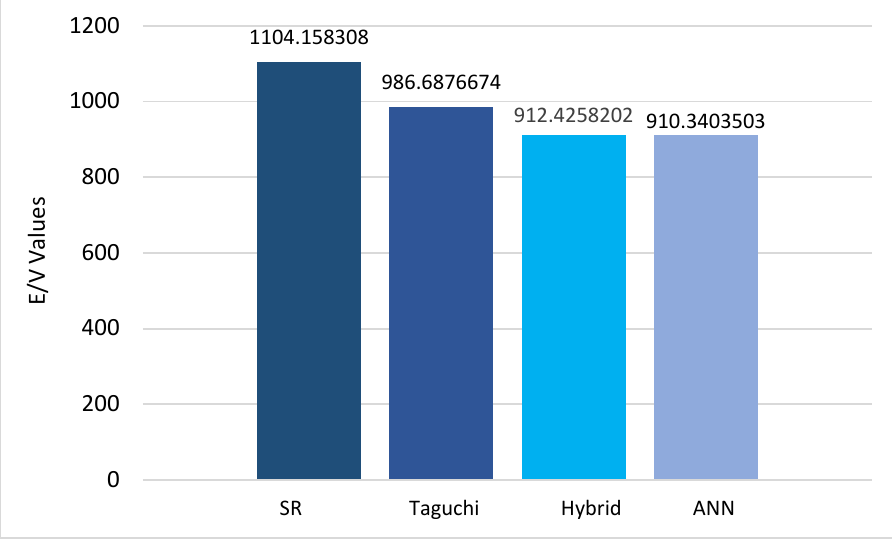
Figure 6. Comparison of E/V values obtained through straight run (SR), Taguchi technique, hybrid framework, and ANN model.